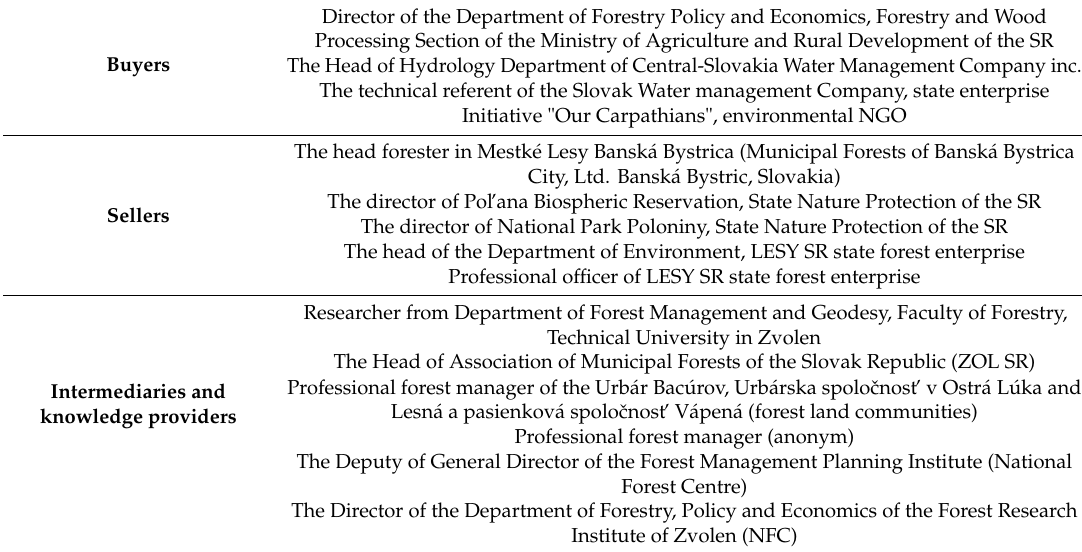
Table 2. The main actors in PWS schemes in Slovakia.